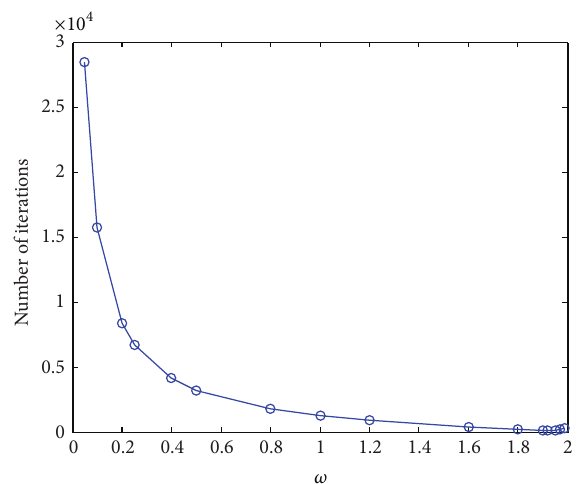
Figure 4: Numbers of iterations and 𝜔 values for Example